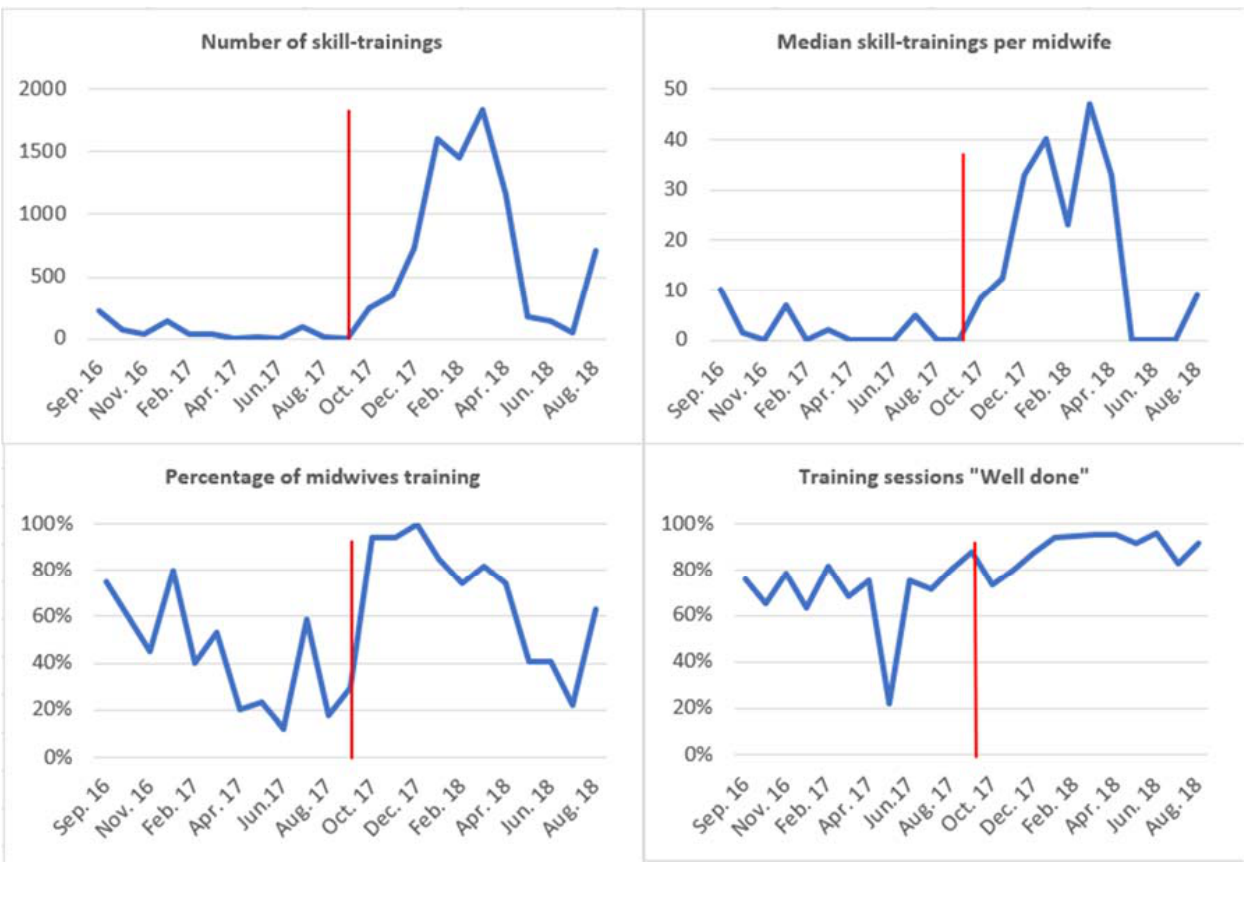
Figure 4. Timelines for number of skill ‐ trainings, median number of skill ‐ trainings per midwife, percentage of midwives participating in training and percentage of sessions receiving feedback “well done”.